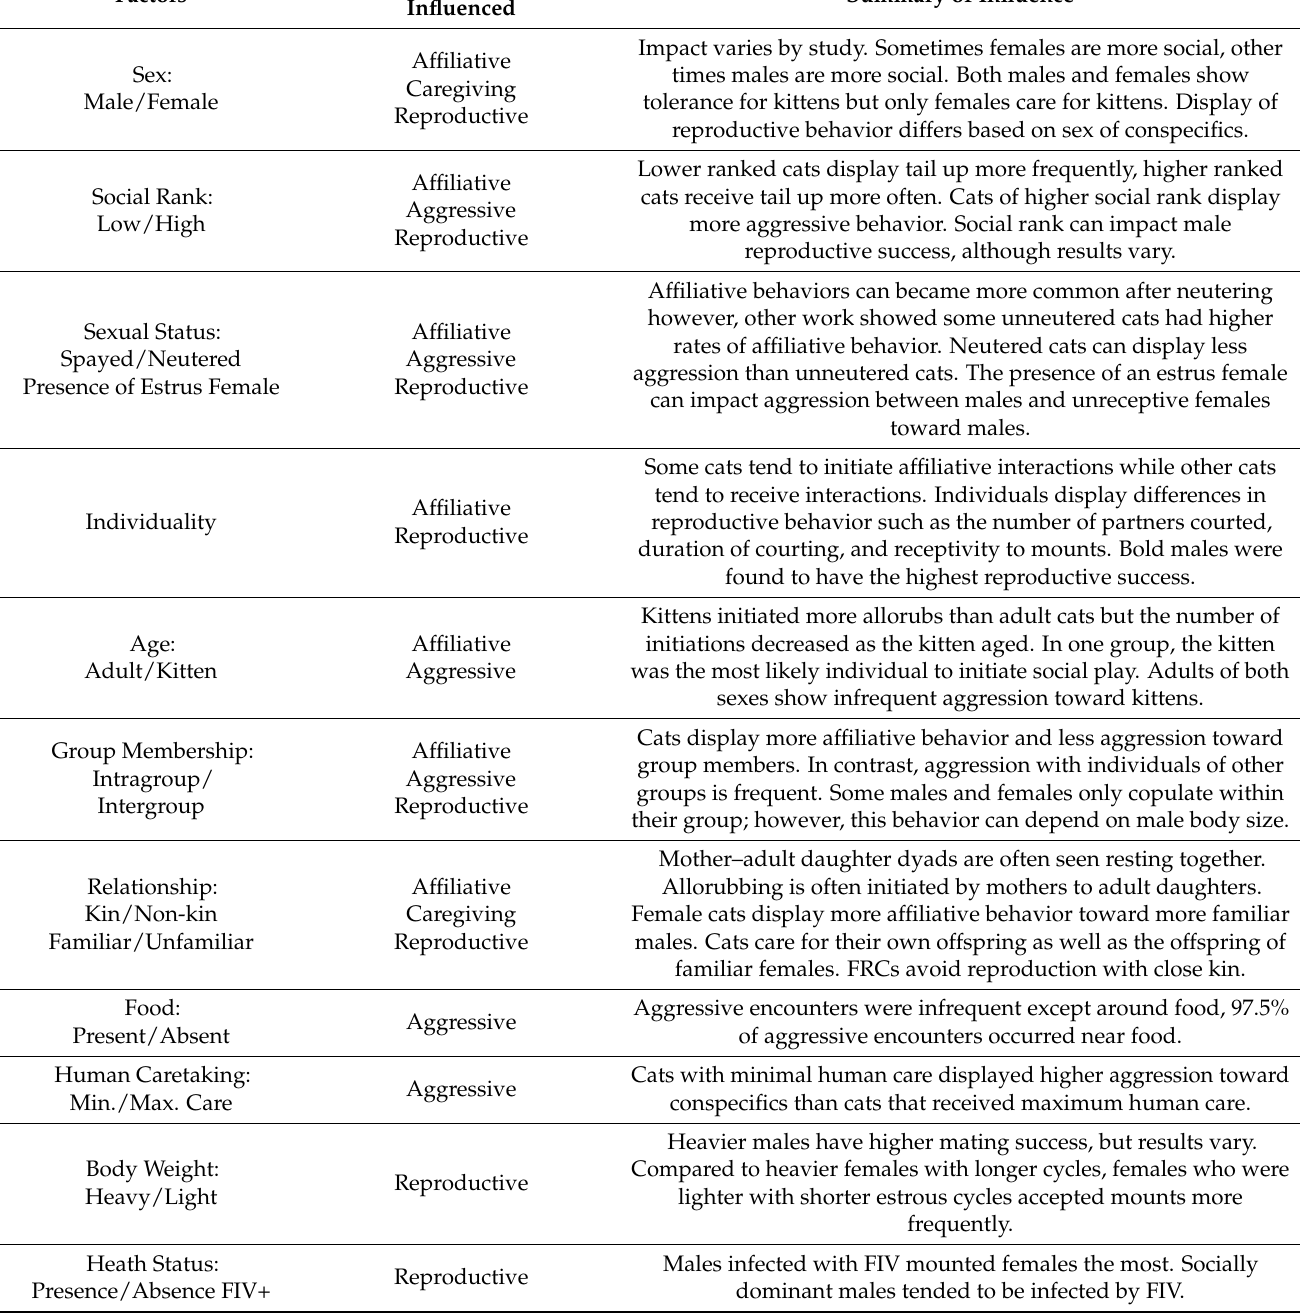
Table 2. Factors that influence FRC intraspecific social behavior. The factor, behavioral category influenced, and a summary of each influence are